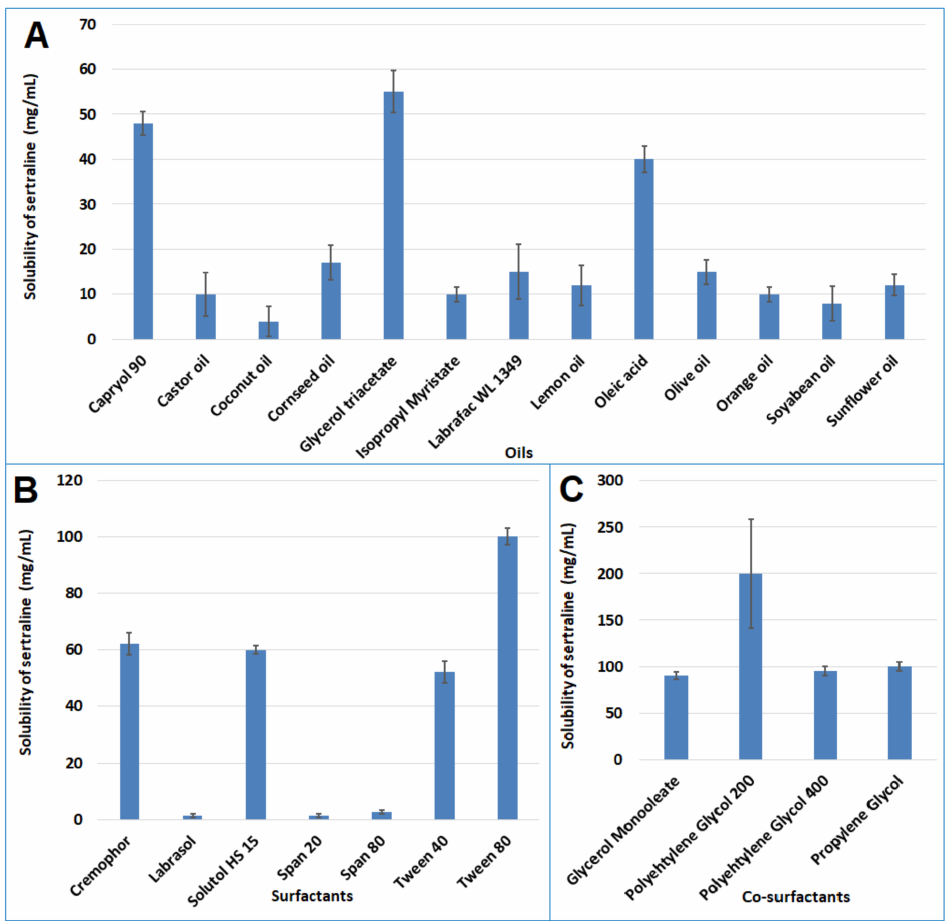
Figure 2. Solubility profile of sertraline in various components of self-nanoemulsifying drug delivery system; ( A ) oils; ( B ); surfactants; ( C )